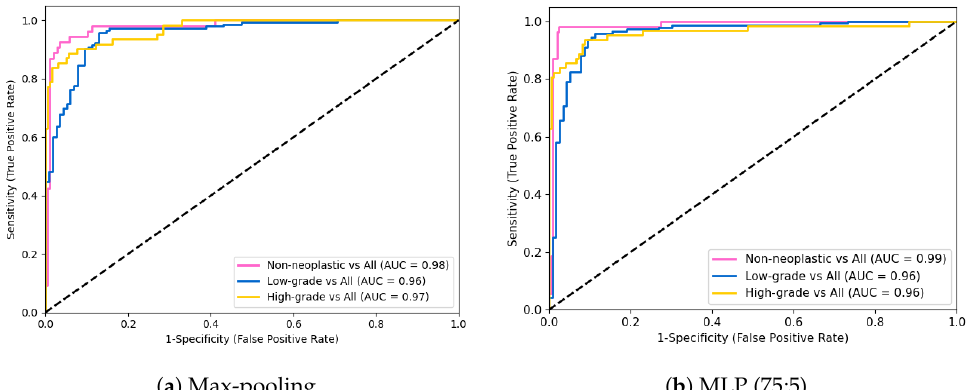
Figure 5. ROC curves for max-pooling and MLP (75;5)